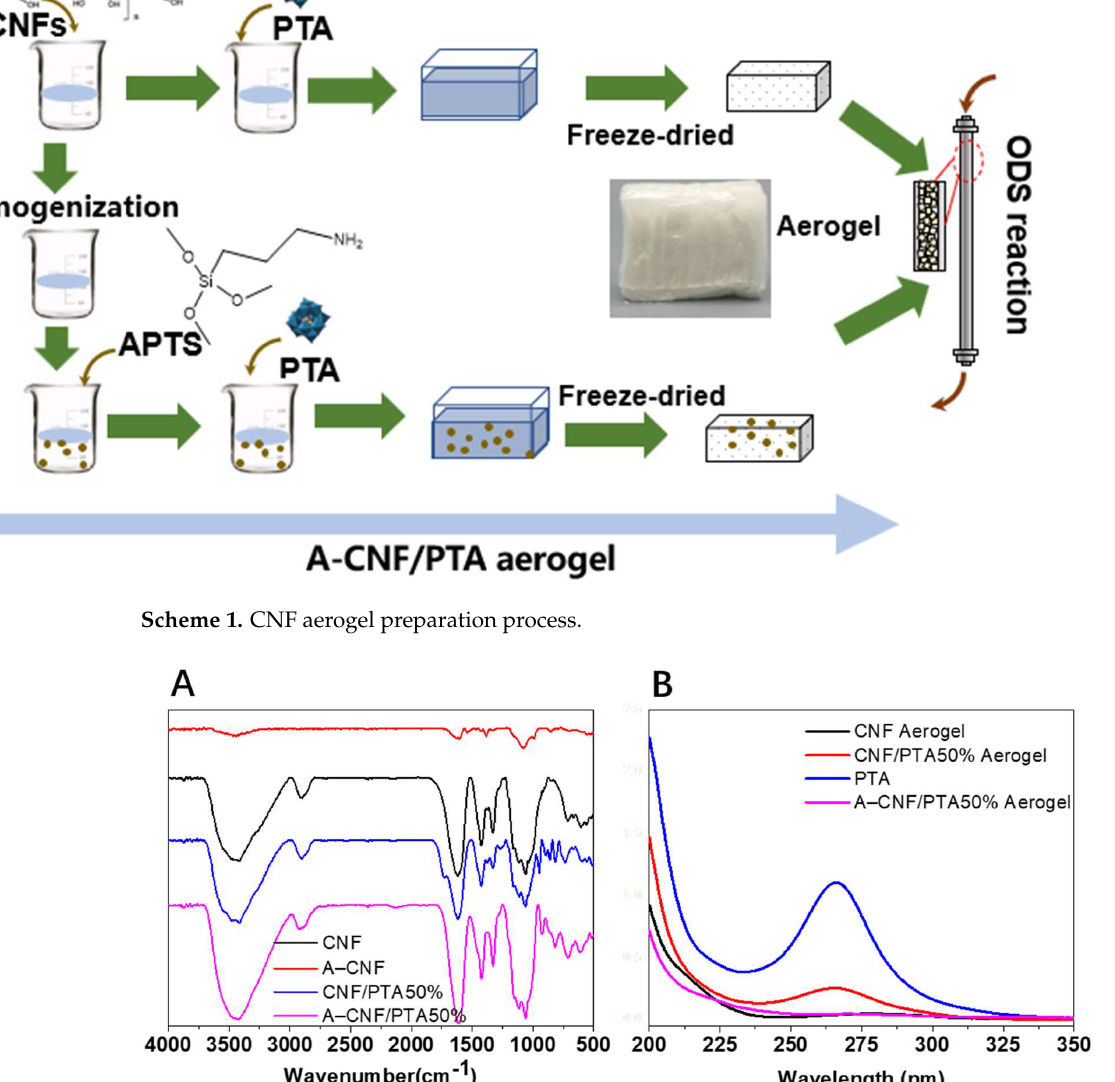
Figure 1. FT-IR spectra of the aerogels CNF, CNF/PTA50%, and A-CNF/PTA50% ( A ), and UV spec- trum of the solution after immersion of aerogels ( B ).